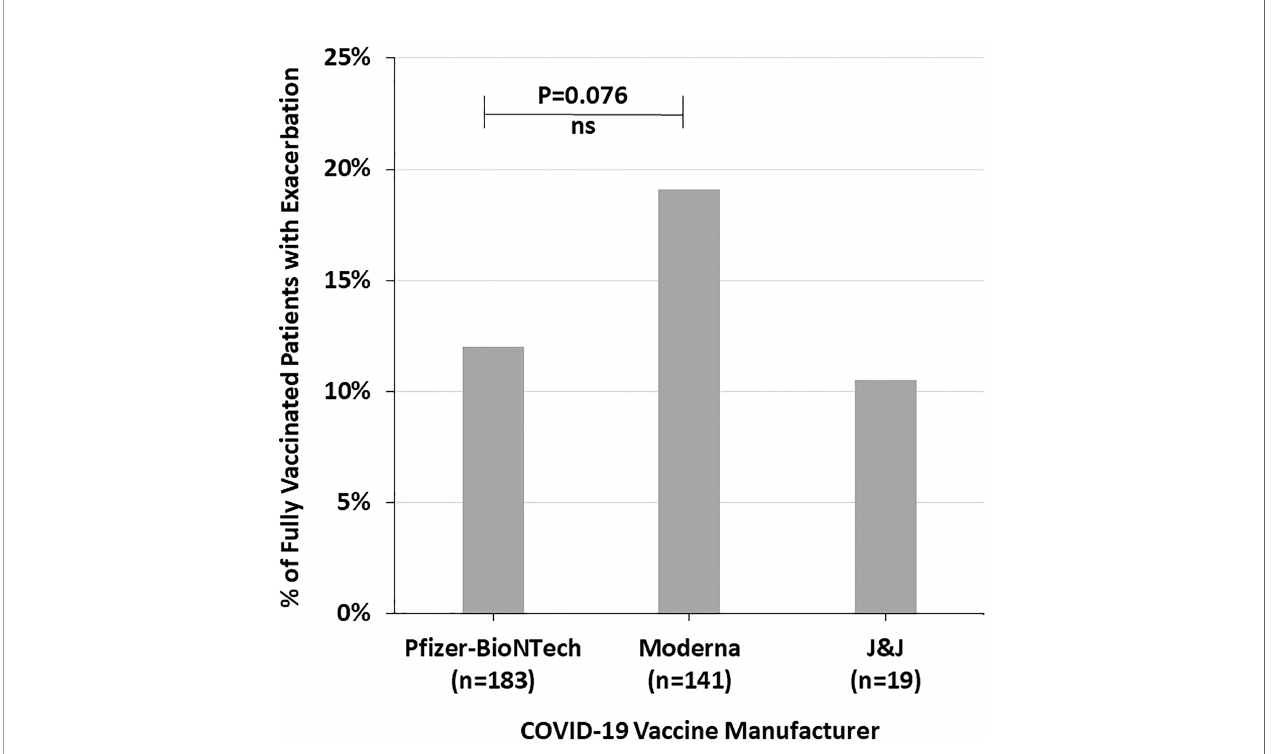
FIGURE 3 | The percent of fully vaccinated patients reporting symptoms of autoimmune disease exacerbation after the COVID-19 vaccine by vaccine manufacturer, highlighting the trend of increased incidence with the Moderna vaccine. NS, Not signi fi cant.